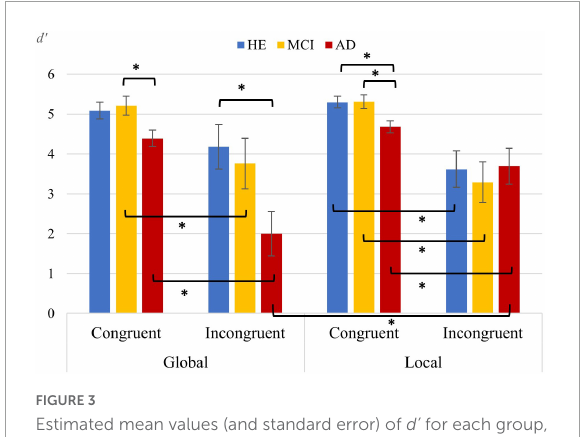
FIGURE3 Estimated mean values (and standard error) of d’ for each group, task, and congruency in the Navon task. ∗ Significant differences from pairwise comparisons for the factors Group × Task × Congruency. Group: HE, healthy elderly; MCI, mild cognitive impairment; and AD, Alzheimer’s disease. Task : global and local. Congruency : congruent and